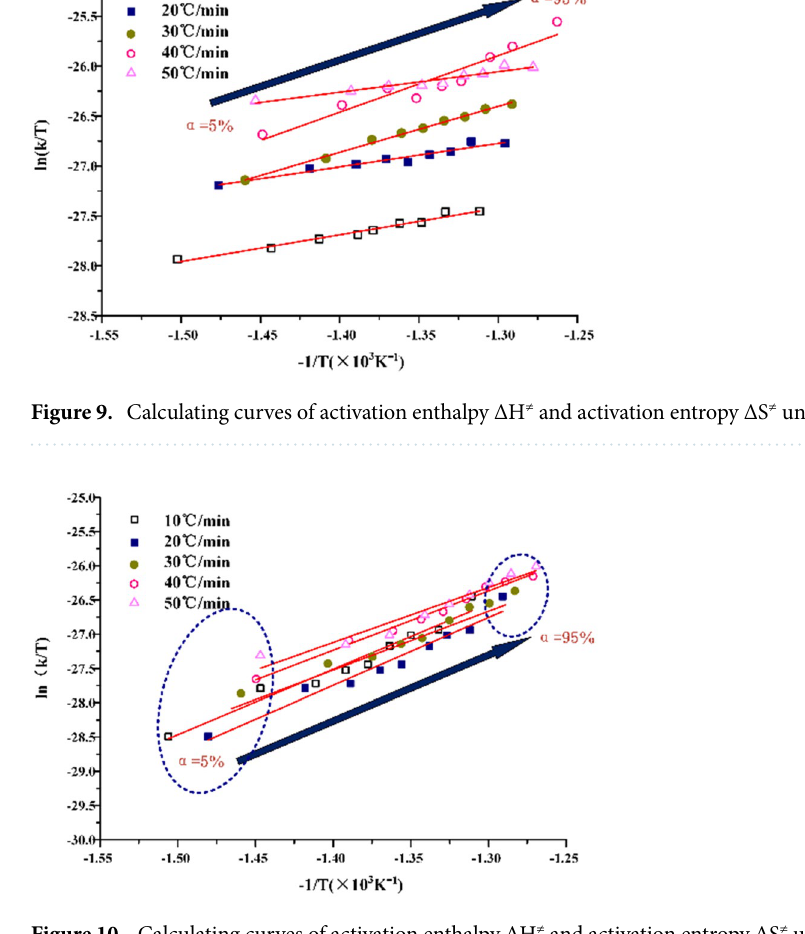
Figure 10. Calculating curves of activation enthalpy ΔH ≠ and activation entropy ΔS ≠ under CO 2